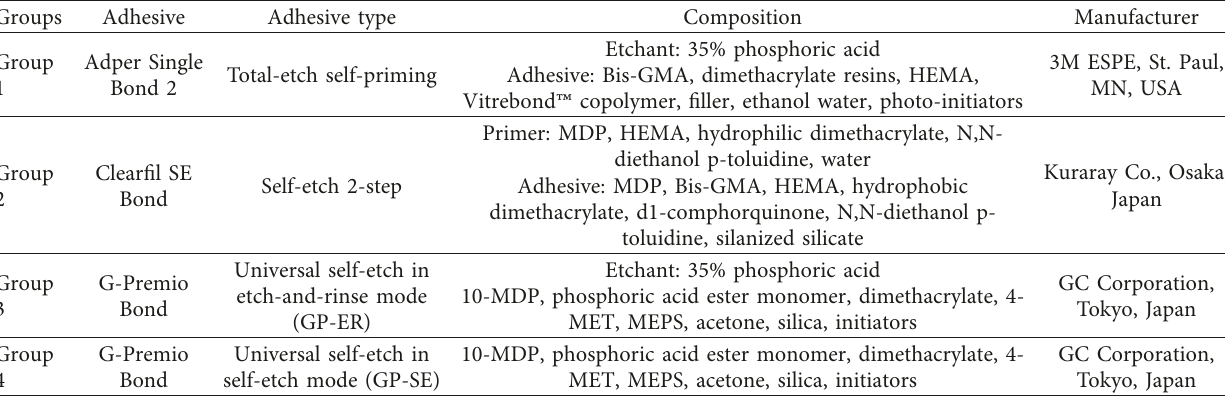
Table 1: The characteristics and compositions of adhesive systems used in each experimental group ( n � 17).